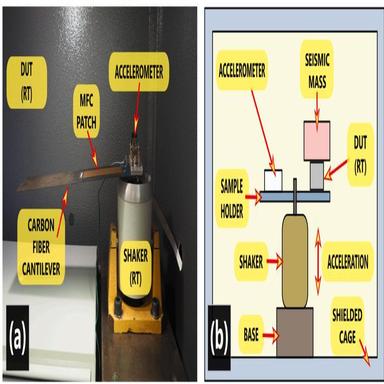
Example of sample montage for room temperature testing of (a) piezoelectric cantilever; (b) schematic diagram of sample montage and placement in shielded cage for the testing procedure analogous to the presented in high temperature configuration shown in. (https://doi.org/10.6084/m9.figshare.12585023) (https://doi.org/10.6084/m9.figshare.12585023) CC BY 4.0 license].